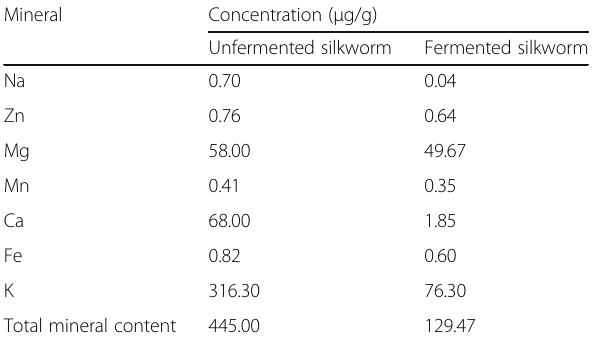
Table 3 Mineral content of unfermented, and fermented